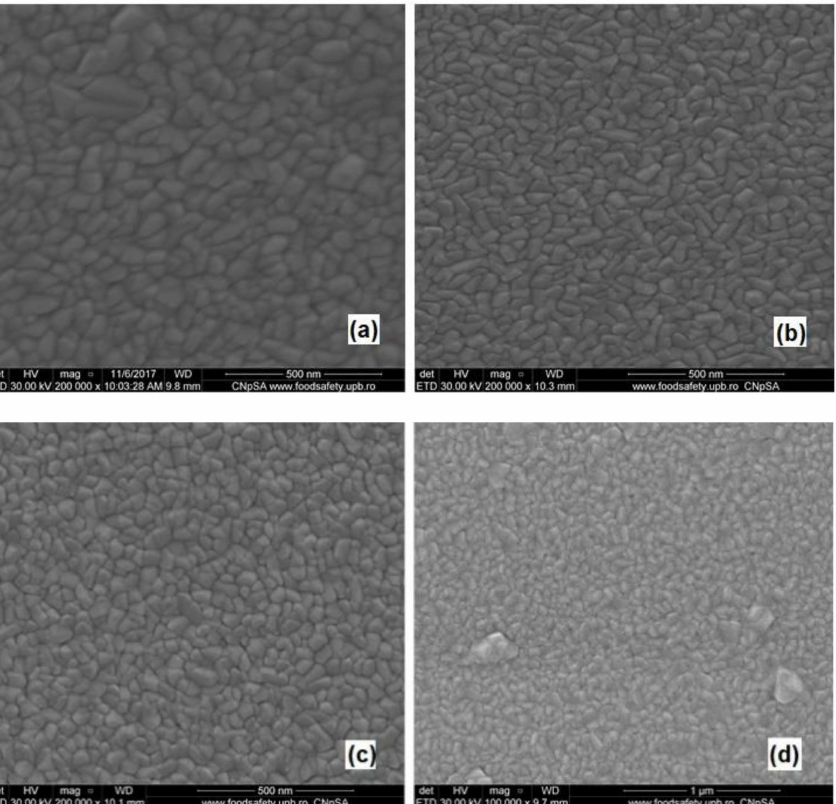
Figure 4. SEM images of Cu 2 O thin films deposited on quartz substrate: ( a ) Sample 0, ( b ) Sample 1, ( c ) Sample 2, and ( d ) Sample 3